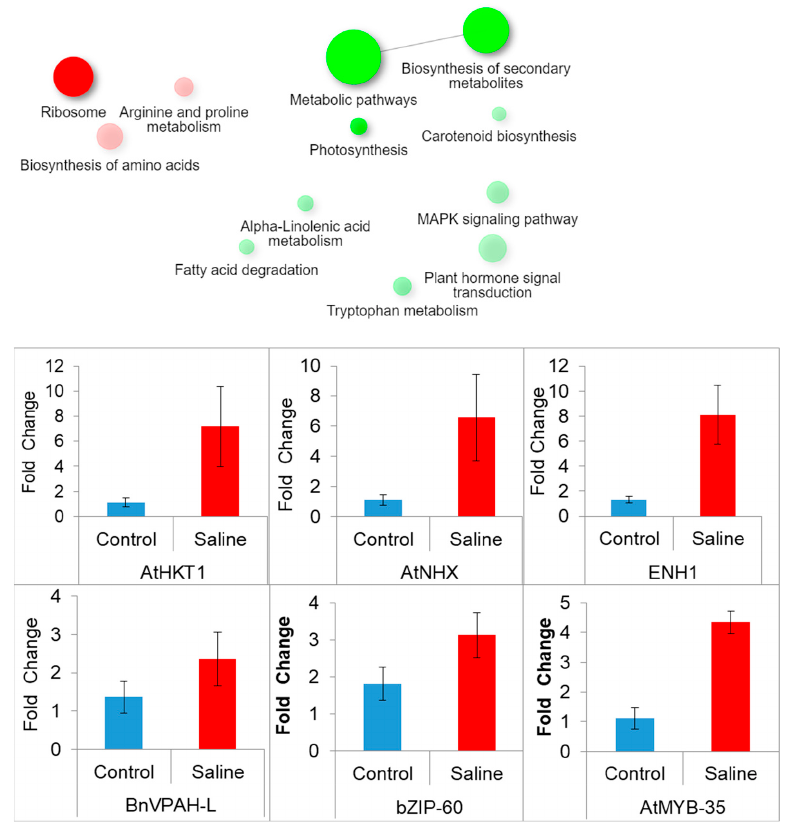
Figure 6. Enriched KEGG pathways up-regulated (red) and down-regulated (green) in canola ( B. napus L.) grown under salt stress. Gene expression as fold change of six genes from leaf tis- sue of canola ( B. napus L.) salt-sensitive cultivar Oscar subjected to salinity stress (200 mM NaCl). Primer sequences are given in Table set (Figure 7; Table S2(S2a,S2b)).